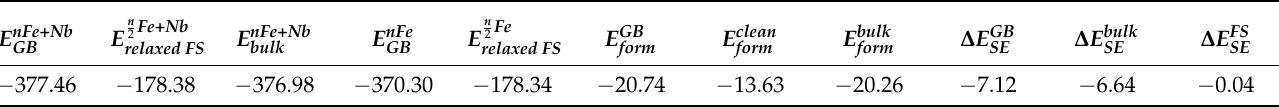
Table 3. Calculated segregation energies of the system with Nb doped in the grain boundary of bcc Fe (eV). n Fe + Nb 2 E nFe + Nb E E nFe + Nb E nFe GB bulk GB relaxed FS − 377.46 − 178.38